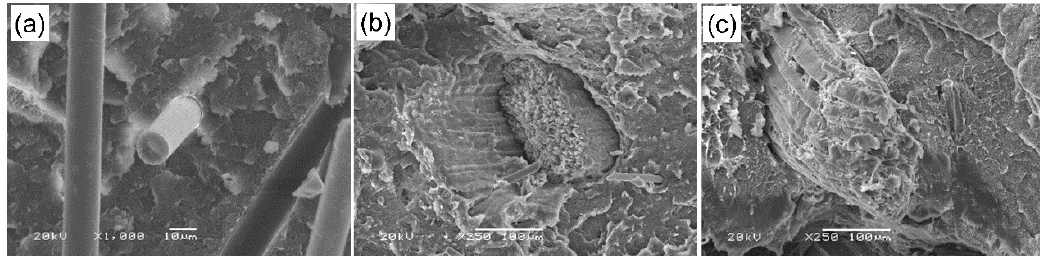
Figure 5. Scanning electron microscopy (SEM) images of composites with 6% wt. fiber content ( a ) polyethylene (PE) with basalt fiber, ( b ) PE with coconut fiber, ( c ) PE with wood flour.